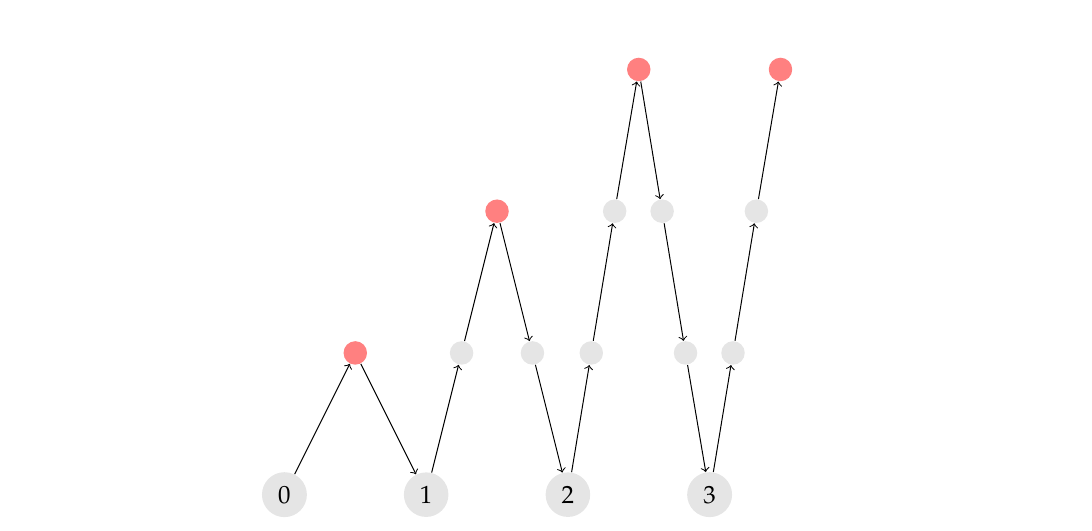
Figure 2. Full multigrid (FMG) method on three levels. The red circles denotes the initial guess after prolongation (cid:37) (interpolation) and (cid:38) shows the